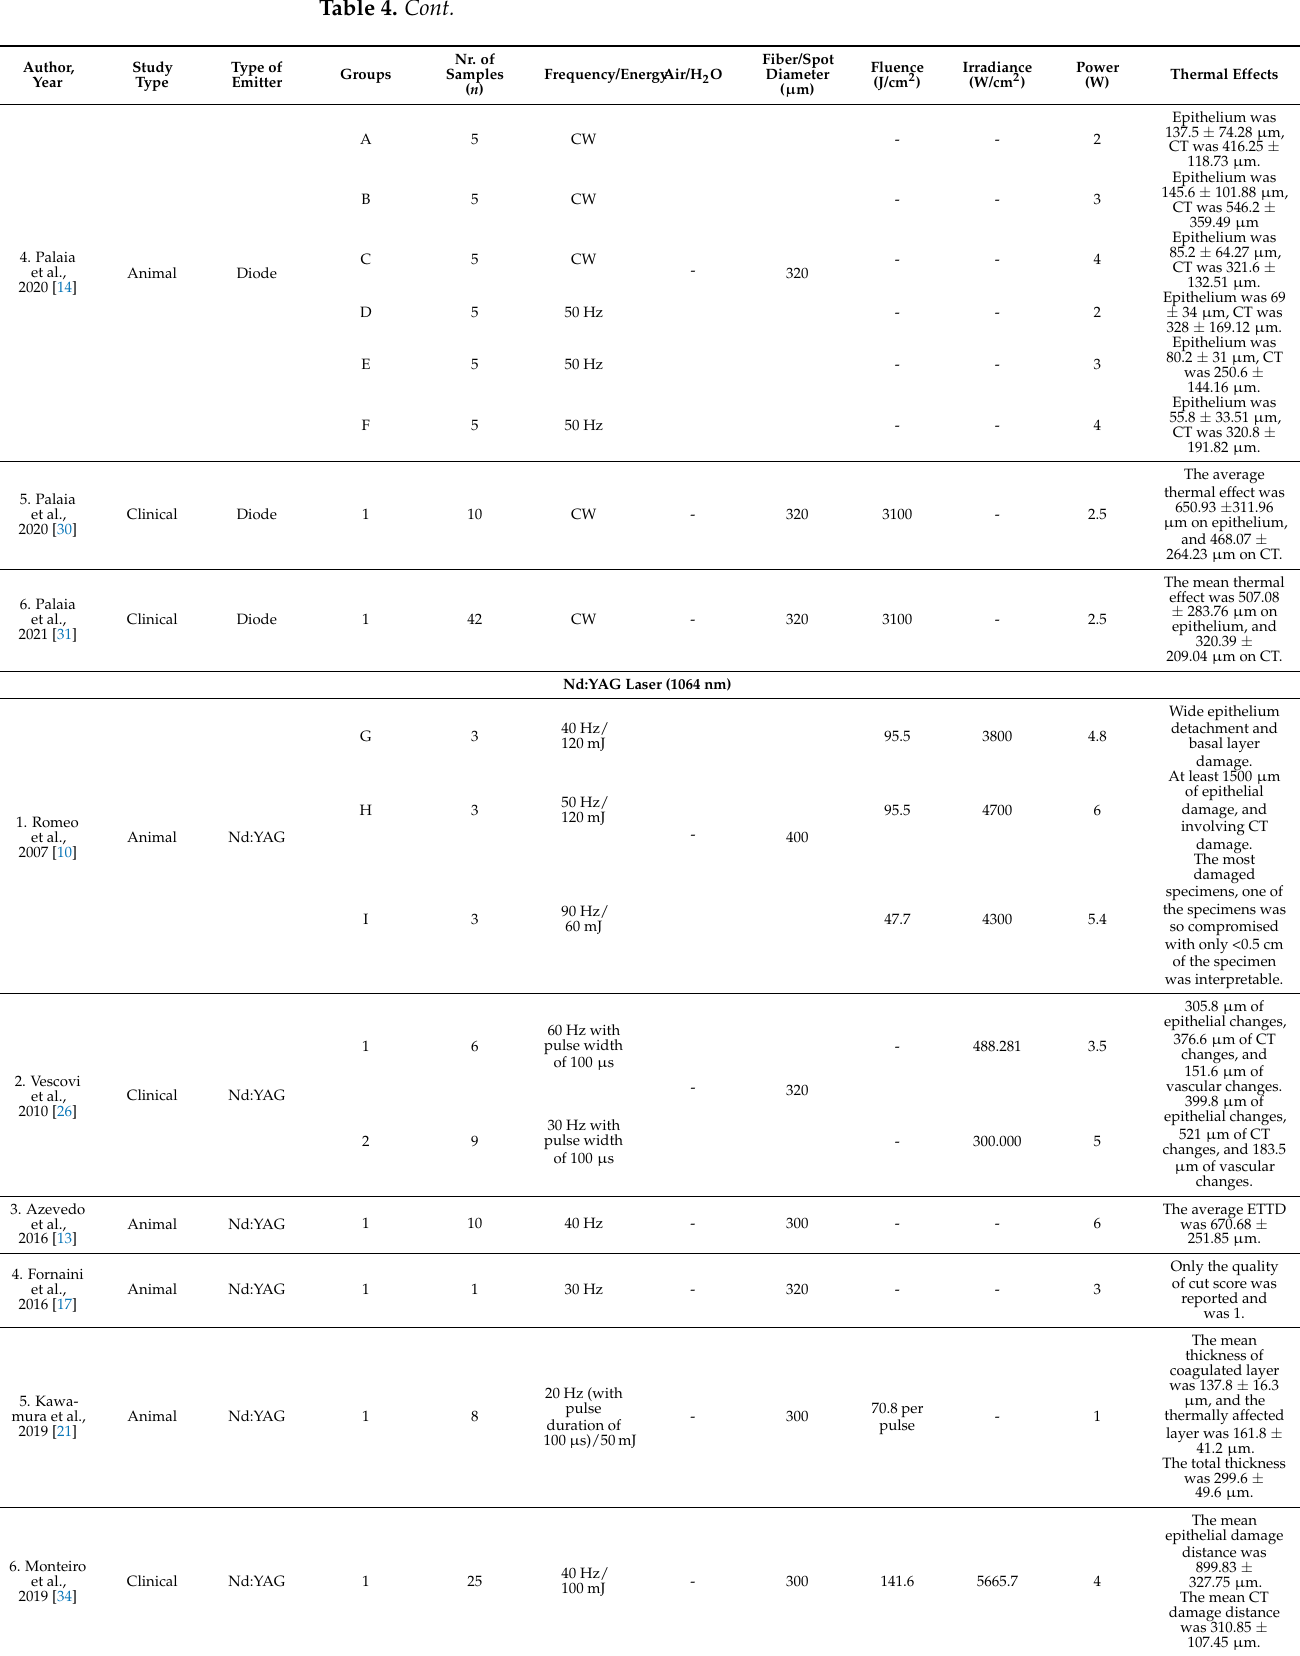
was137.8 ± 16.3 µ m,andthe thermallyaffected layerwas161.8 ± 41.2 µ m. Thetotalthickness was299.6 ± 49.6 µ m. Themean epithelialdamage distancewas 899.83 ± 327.75 µ m. ThemeanCT damagedistance was310.85 ± 107.45 µ